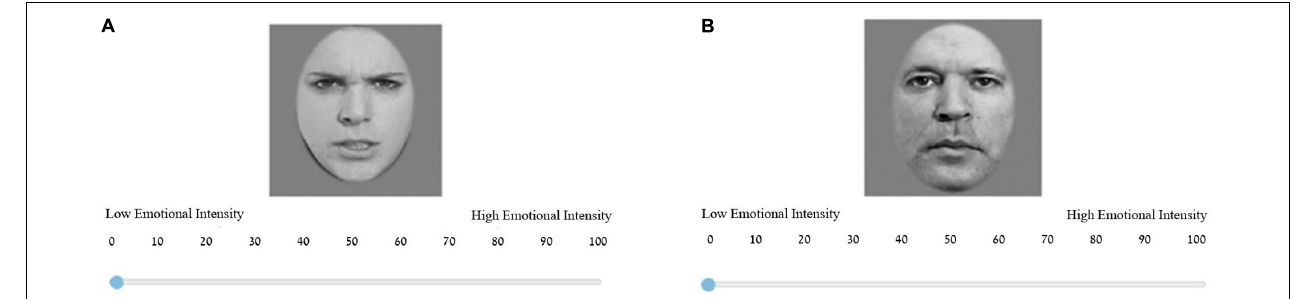
FIGURE 1 | An example of two trials from the experiment. (A) A trial containing an angry female face depicting 90% emotional intensity. (B) A trial containing a happy male face depicting 10% emotional intensity. The picture stimuli database as well as normative data are based on the stimuli created by Blais et al. (2012), and are available at the following address: